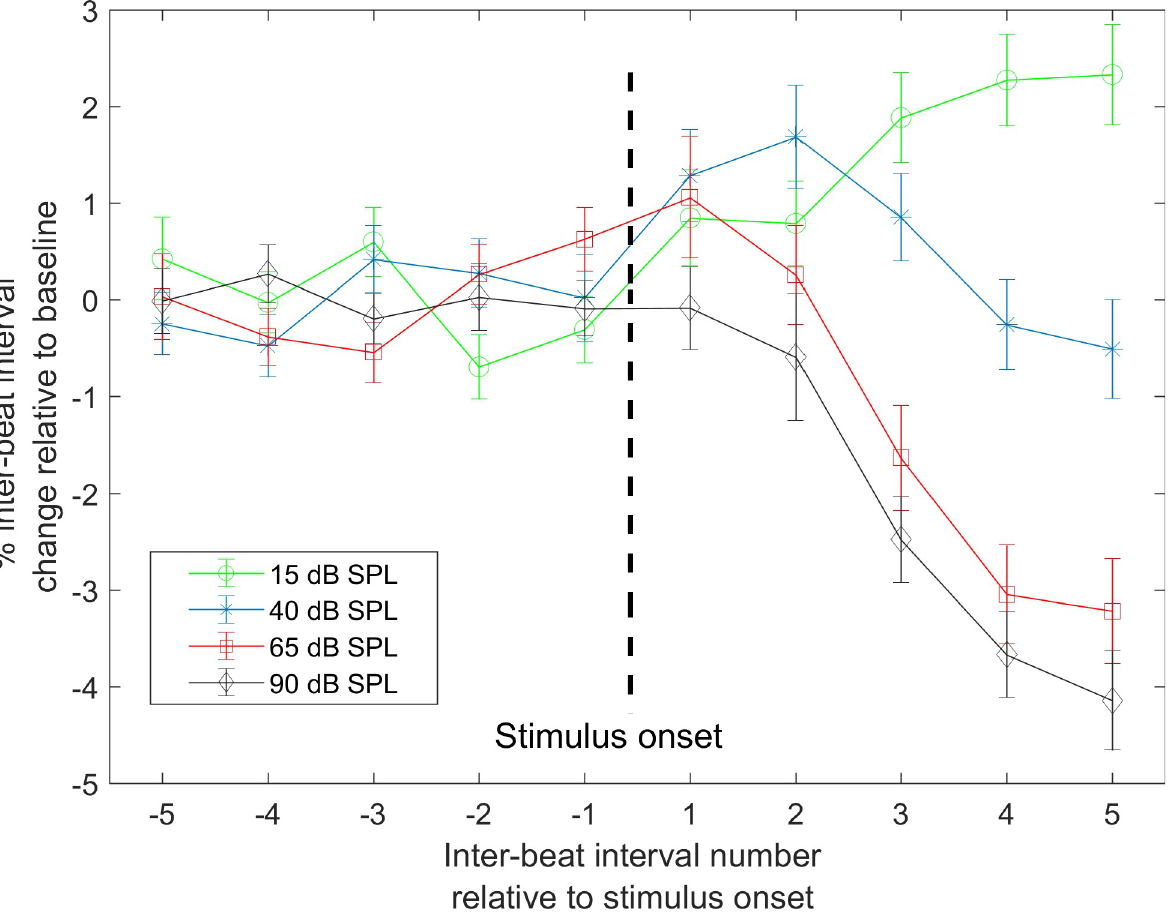
Fig 4. Percentage change in averaged inter-beat intervals relative to baseline. Values averaged across participants (n = 27) are shown. Error bars show standard error of mean (SEM).